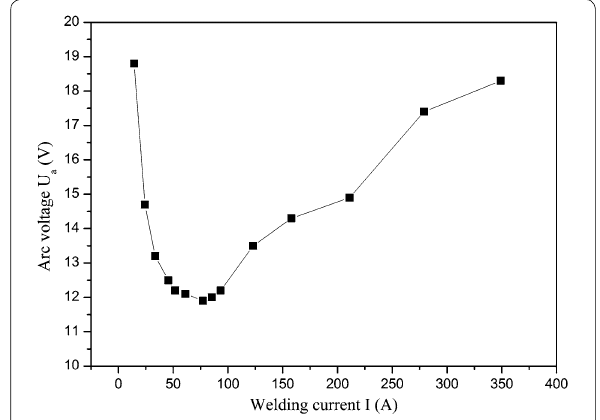
Figure 8 Static characteristic of a traditional TIG